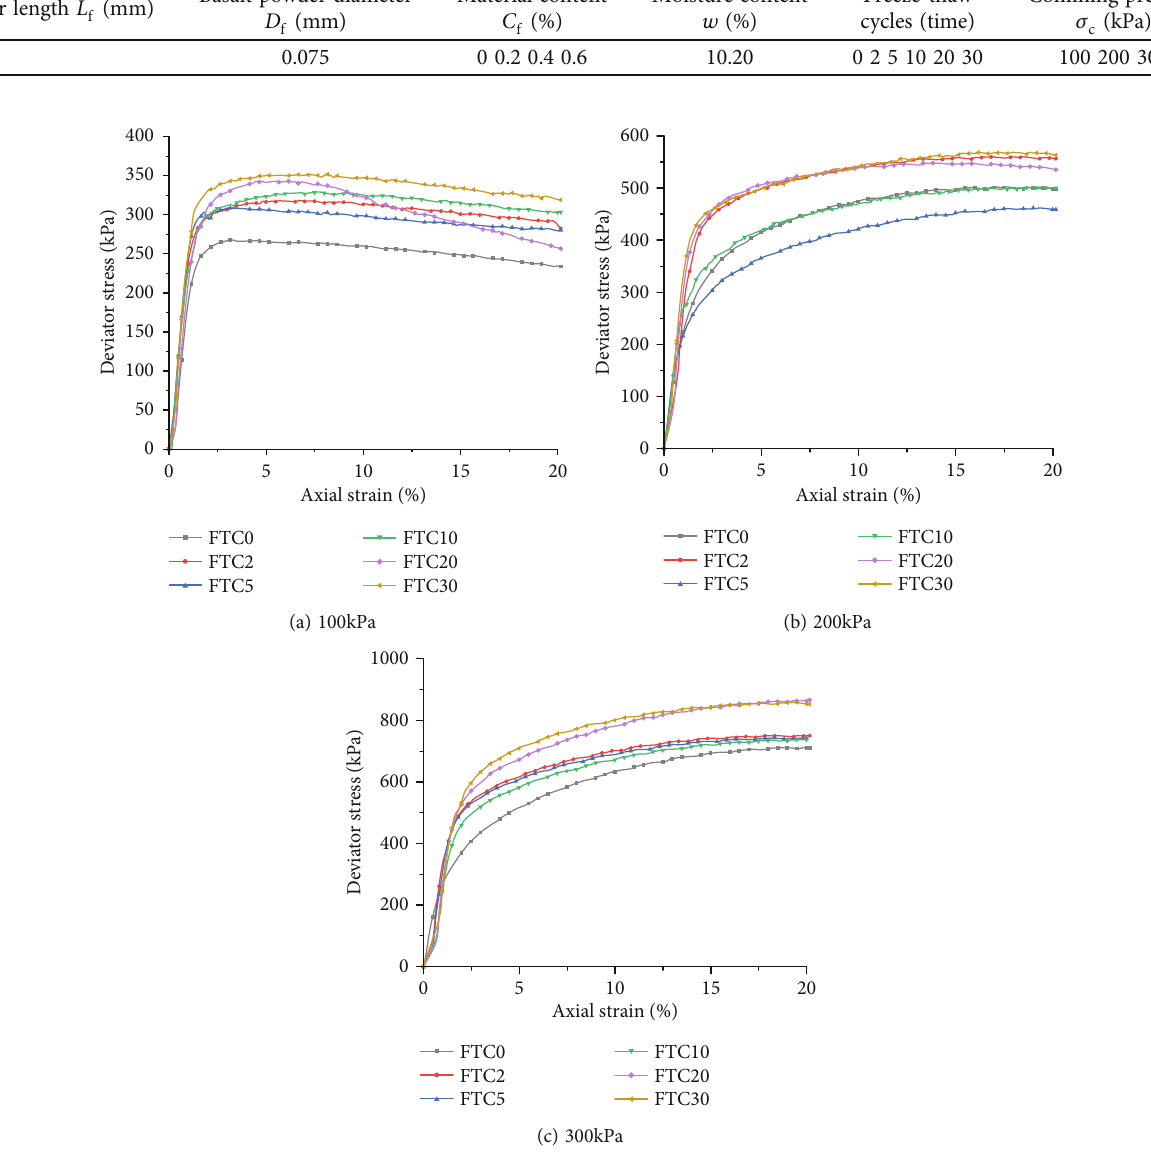
Figure 4: Stress-strain curve of normal